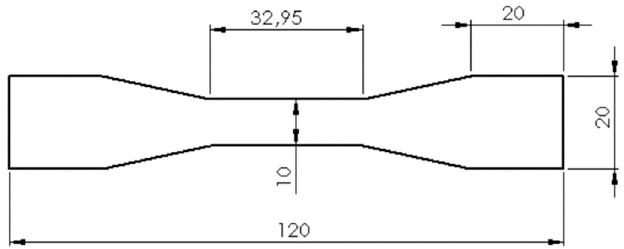
Figure 8. Dog bone configuration sample, dimensions in mm (c) the authors, CC BY-NC-ND 4.0 [17].